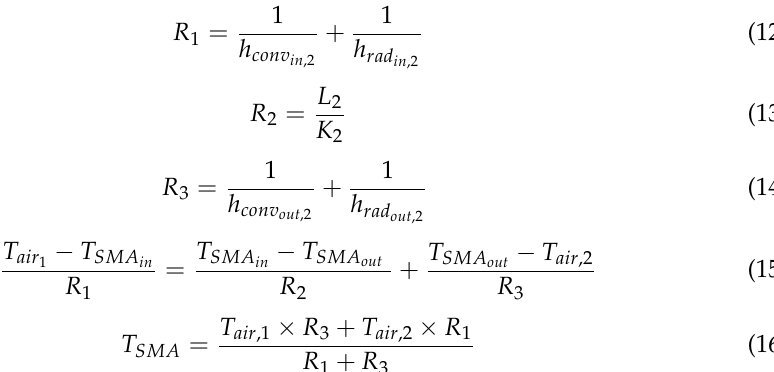
Table 1. Properties of acrylic plastic used for the SHC . Property Value Unit